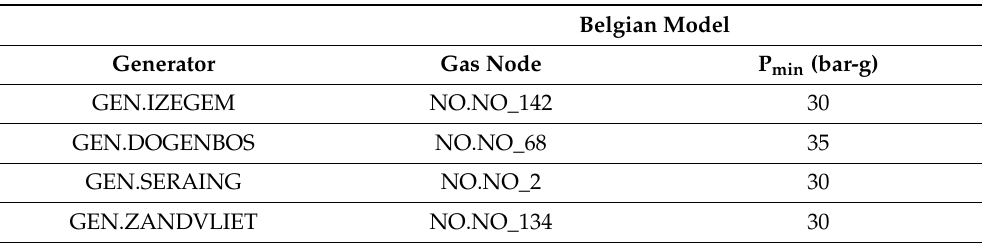
Figure 4. Depiction of the Belgian electricity ( top ) and gas networks ( bottom ). Circles represent electric buses or gas nodes, and the orange trapezoids represent compressor stations. Labels indicate coupled natural gas generators and their gas network nodes. Table 3. Overview of coupled generators and gas nodes in the Belgian network, with the minimum delivery pressure (P min ) at each node.